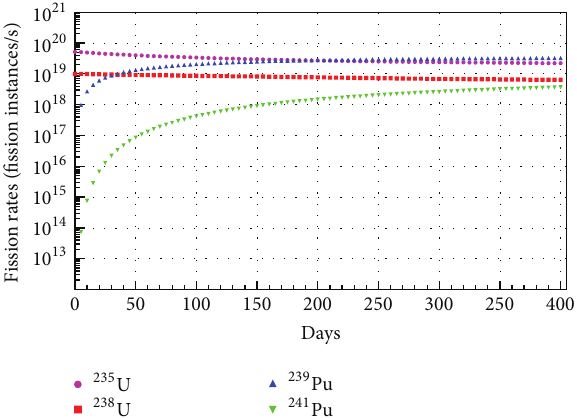
Figure 3: Cross section of a single unit cell. A fuel bar (in red) with Zircaloy cladding (white) immersed in demineralized water as moderator. Complete assembly is formed by 92 of these cells. The values for 𝑅1 , 𝑅2 , and 𝐿 are described in Table 3.